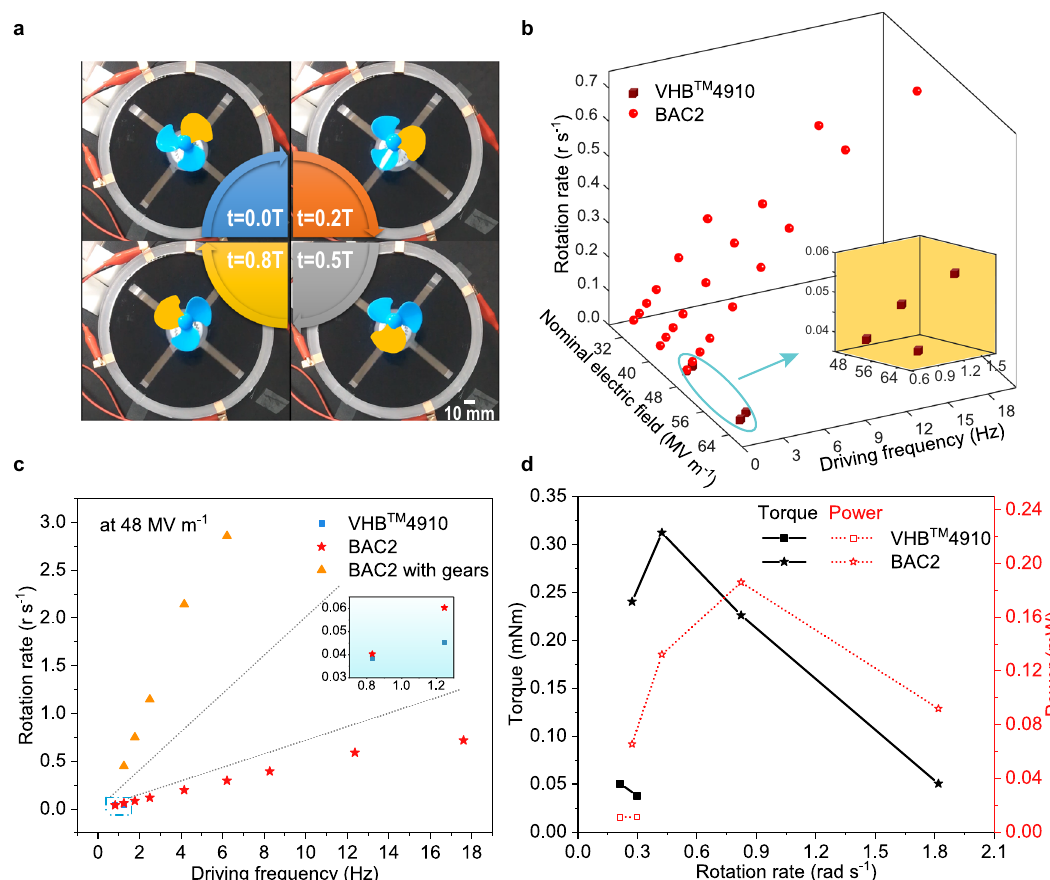
Fig. 4 Mechanical output performance of soft non-magnetic motors made of dielectric elastomer fi lms. a Snapshots from the Supplementary Video 1 of a spinning non-magnetic motor displaying a complete rotation cycle, where t and T denote time and rotation period, respectively. b Dependence of the rotation rate on electric fi eld and driving frequency for the motors made of VHB TM 4910 and BAC2 fi lms. The inset is a magni fi cation of the data indicated by the arrow, which represents the electric fi eld and frequency-dependent behavior of the rotation rate for VHB TM 4910 based motor. c Dependence of the rotation rate on the driving frequency for the VHB TM 4910 and BAC2 based motors as well as BAC2 based motor with transmission gears at 48 MV m − 1 . d Comparison of the output torque and power of VHB TM 4910 and BAC2 based